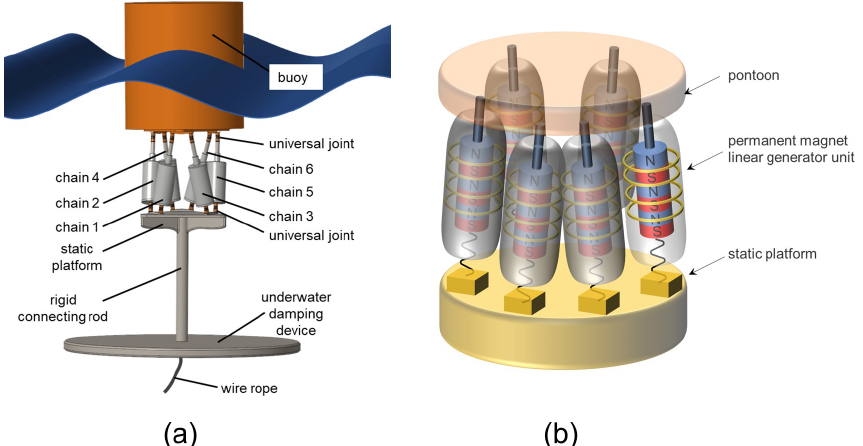
Figure 1. The wave energy converter based on 6-DOF parallel mechanism. (a) The whole device. (b) Power generation schematic diagram of the